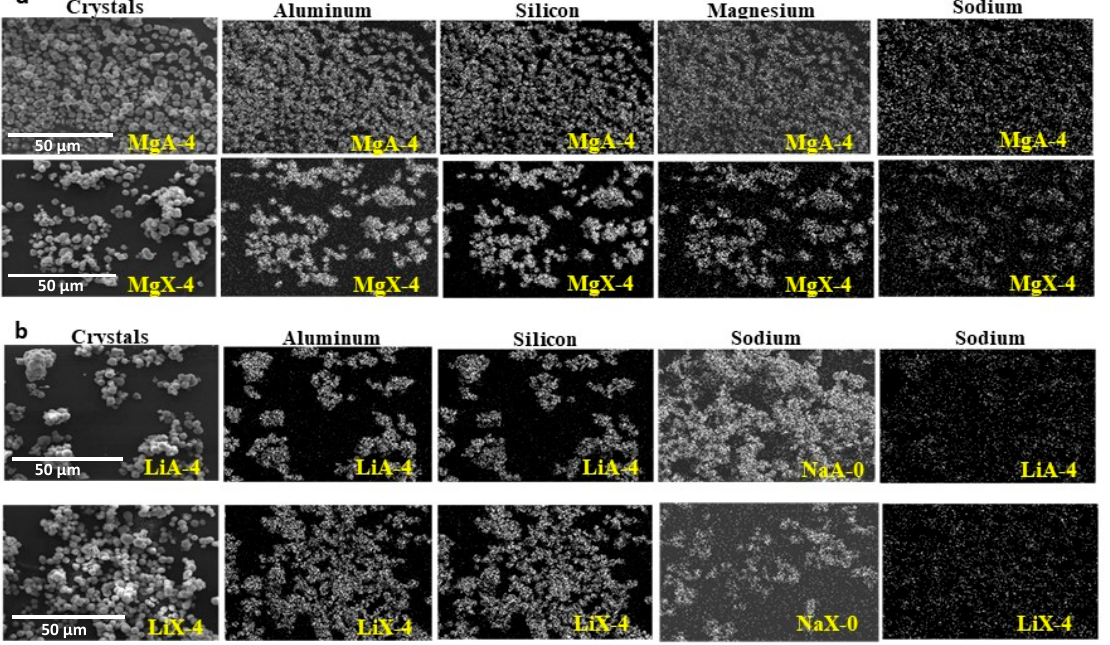
Figure 4. EDX mapping of aluminum, silicon, sodium and magnesium elements present in ( a ) MgA-4, MgX-4 and ( b ) LiA-4, LiX-4 samples and sodium mapping in the raw materials. The scale is similar for all sample series.